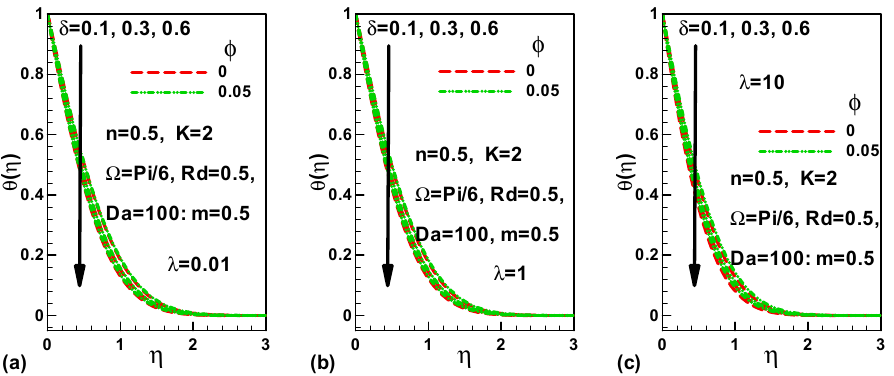
Figure 5. Variation of dimensionless temperature with slip parameter and solid volume fraction of nanoparticles for ( a ) forced convection, ( b ) mixed convection, and ( c ) free convection.